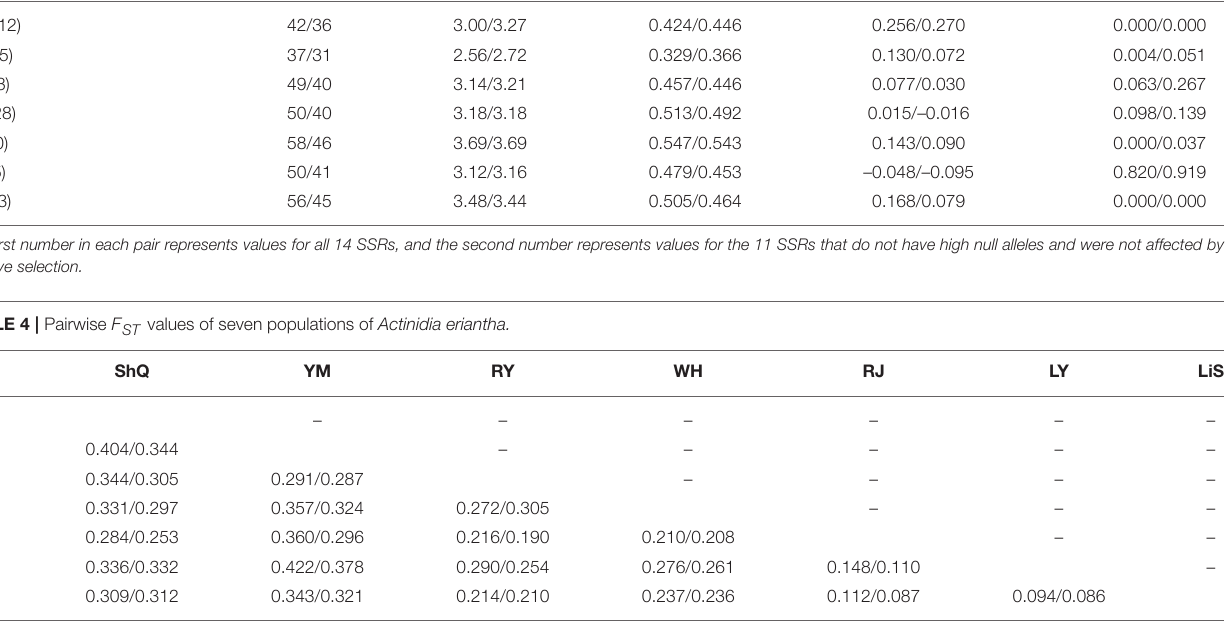
TABLE 3 | Population genetic diversity and inbreeding parameters for Actinidia eriantha. N A R S H E F IS p- value of Population code (number of individuals)